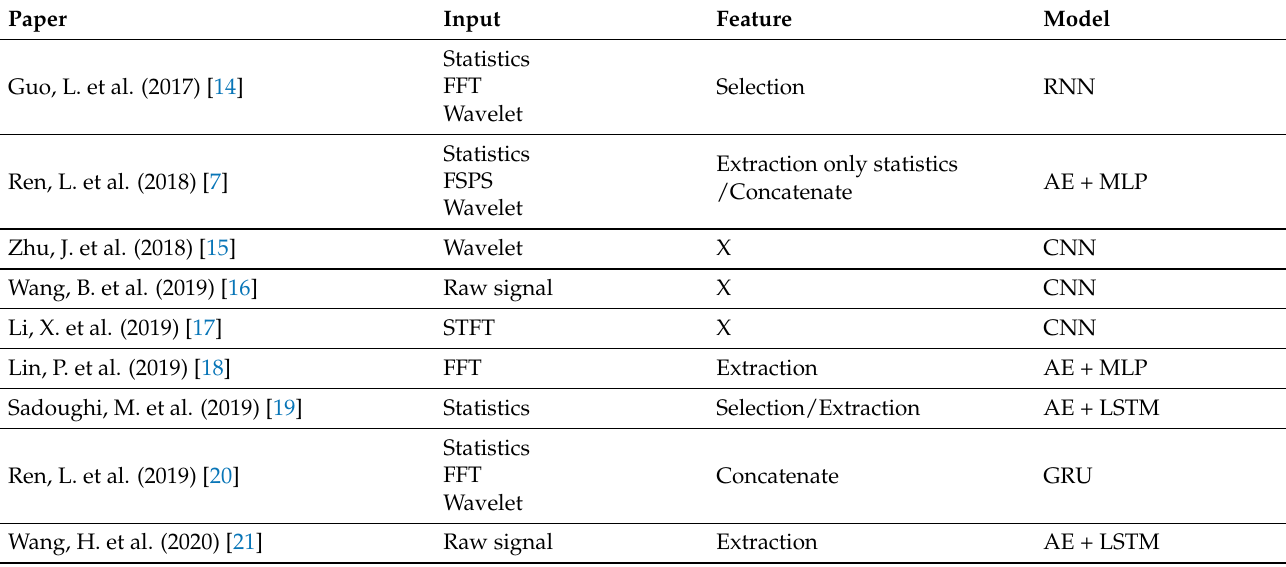
Table 1. The comparison of inputs, features, and models of key